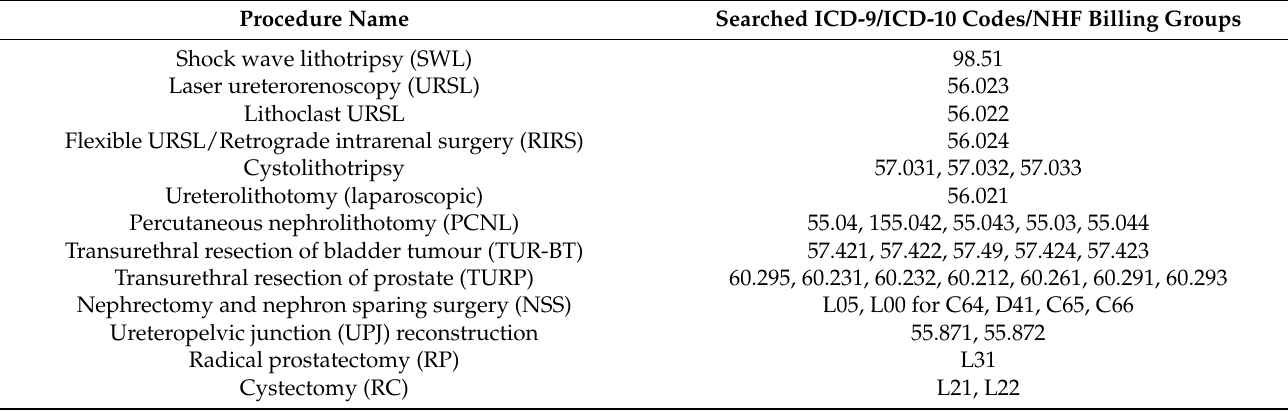
Table 1. Procedure names, codes and billing